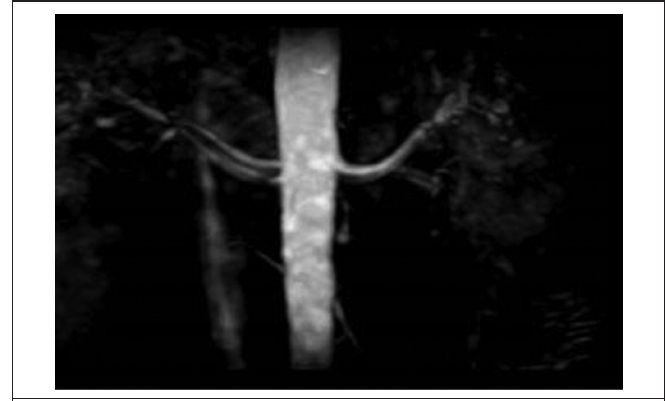
Figure 2. Inhance sequence in a 53-year-old male patient. Coronal reformatted MIP images for (A) main renal arteries (VP 2-3-3), (B) segmental branches (VP 1-1-1), and (C) interlober branches (VP